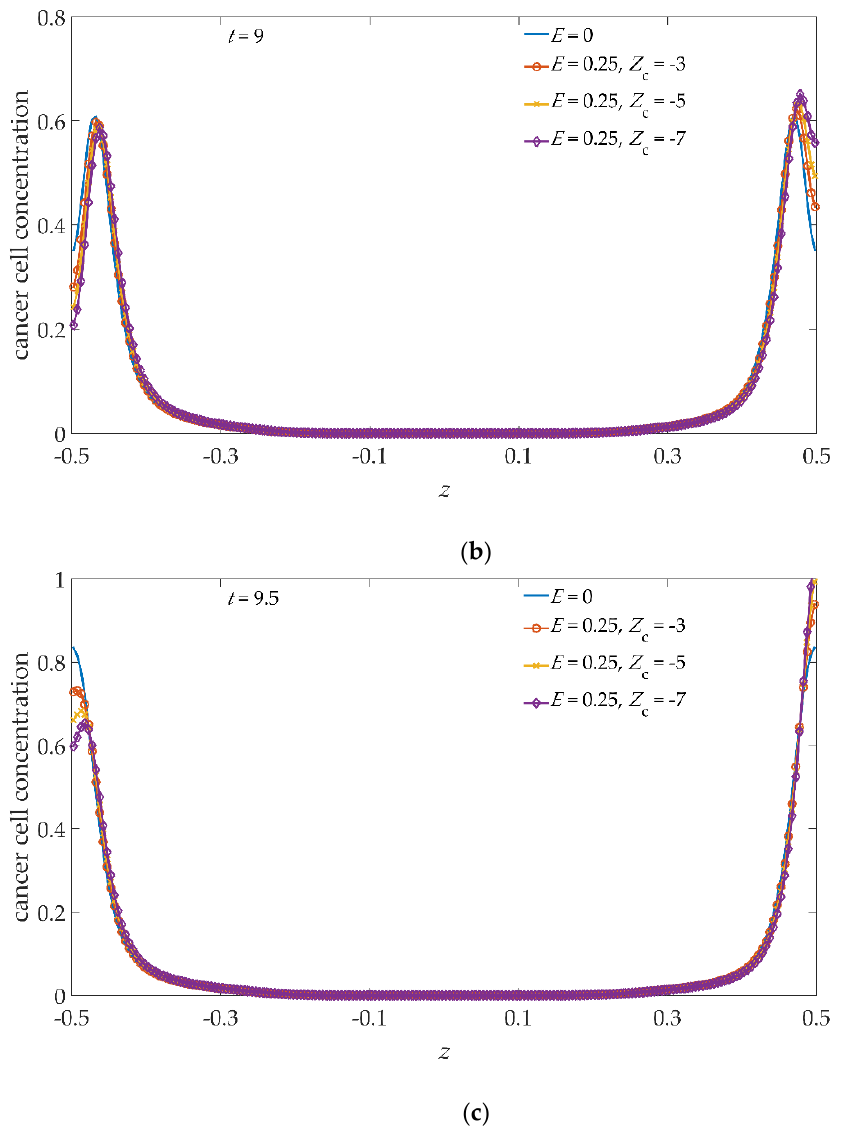
Figure 6. A comparison of the profiles of the cancer cell concentration along the vertical cutline. ( a ) t = 8; ( b ) t = 9; and ( c ) t = 9.5. In each panel, the blue line refers to E = 0, the red line/circle refers to E = 0.25, Z c = − 3, the yellow line/cross refers to E = 0.25, Z c = − 5, and the purple line/diamond refers to E = 0.25, Z c = − 7.